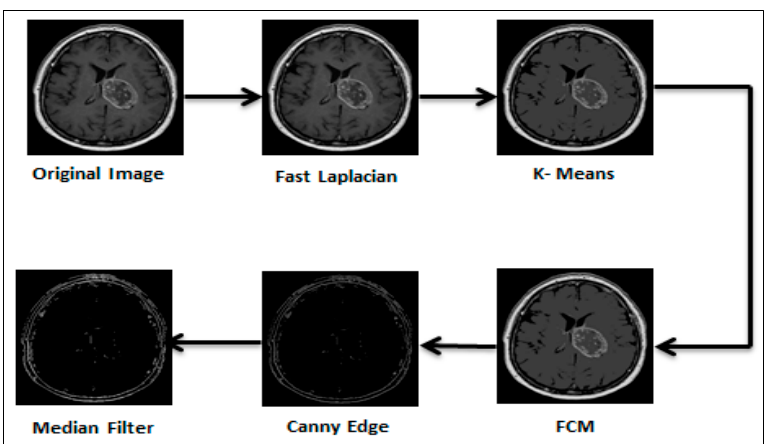
Figure 6. Edge detection algorithm.